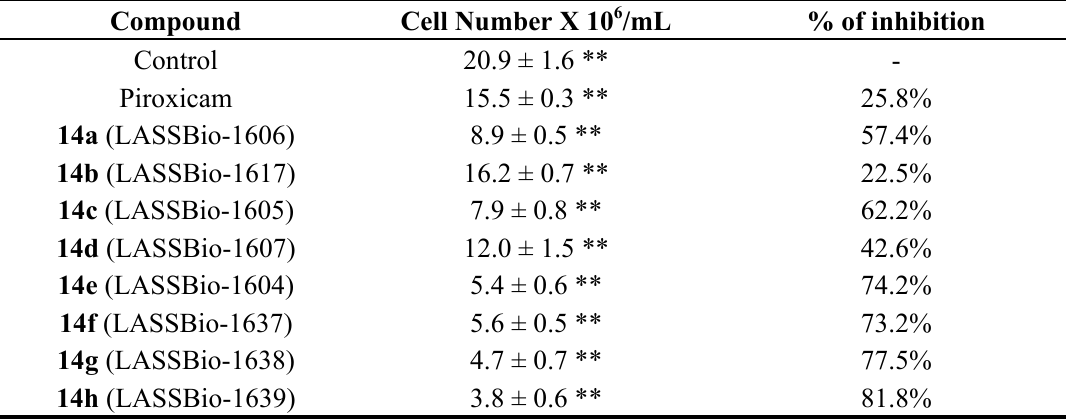
Table 5. Effect of piroxicam NAH analogues and piroxicam (100 μ mol/kg,